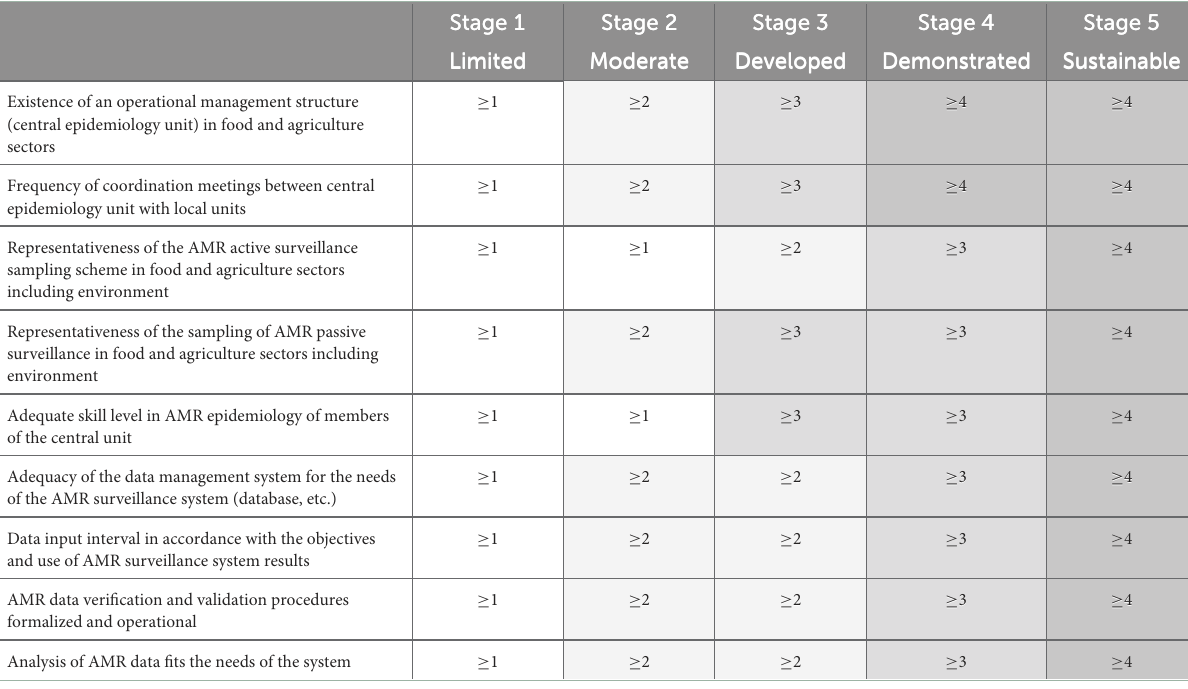
TABLE 5 Approach for the determination of the FAO-ATLASS PIP stage of the “data collection and analysis”